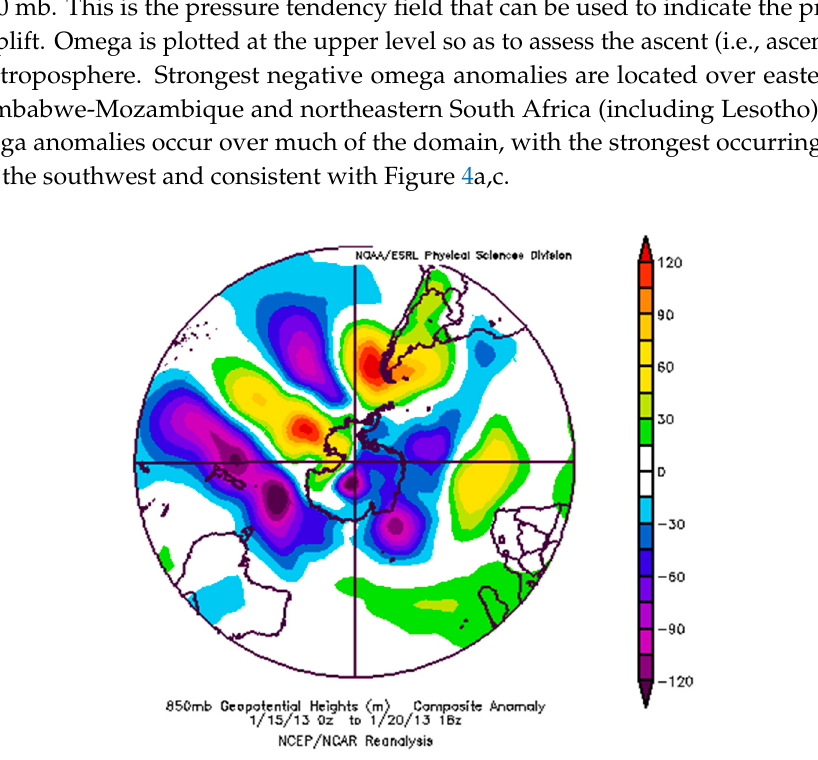
Figure 5. Southern Hemisphere geopotential height anomalies at 850 Figure. 5: Southern Hemisphere geopotential height anomalies at 850 hPa